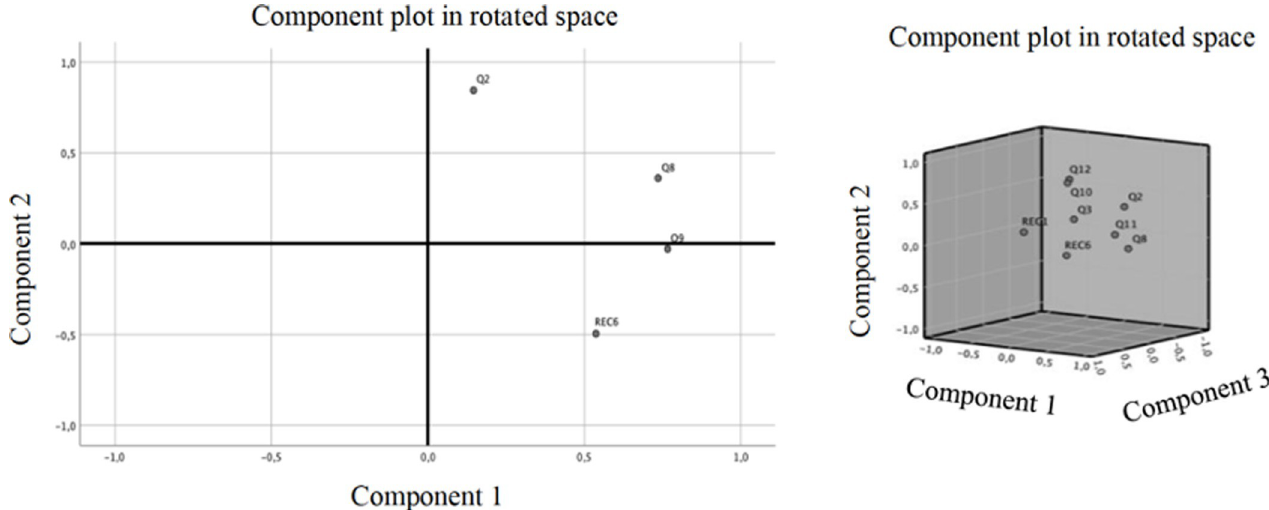
Fig 2. Rotated component graphs for IGs (image on the left side) and for DLGs (image on the right side).